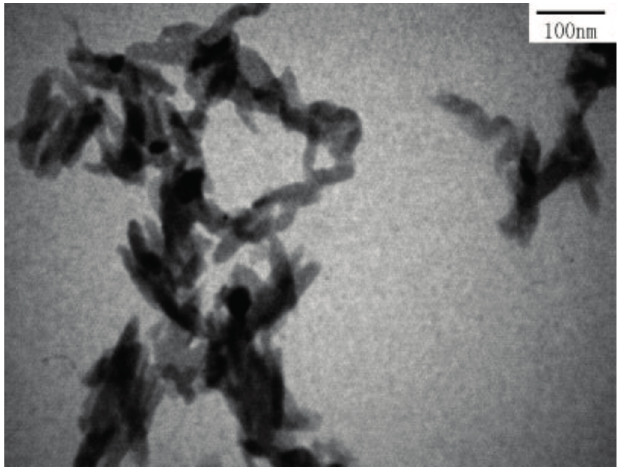
Figure 10. Transmission electron microscopy (TEM) image of Hydroxyapatite nanoparticles. Reprinted with permission from [15], Copyright © 2007 Wiley Periodicals,